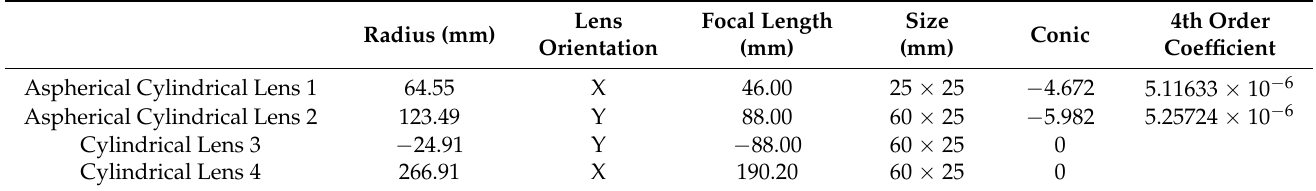
Table 4. Geometric parameters of cylindrical lenses.